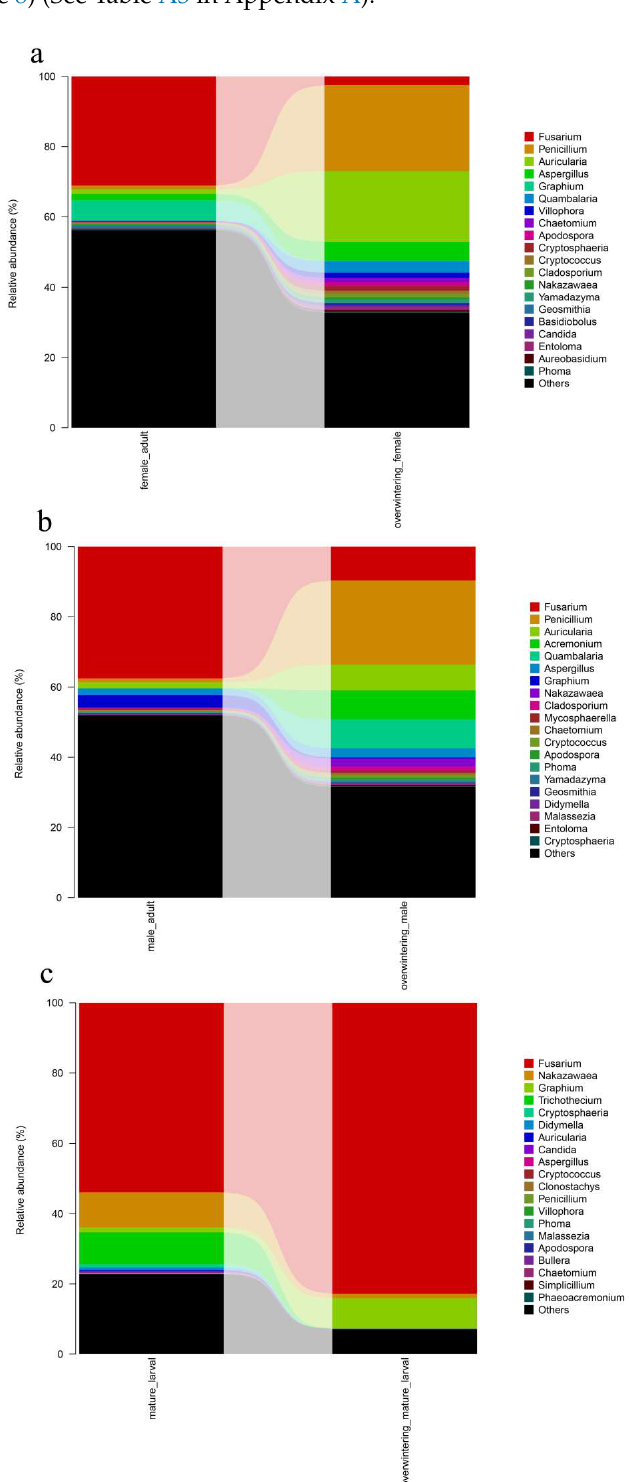
Figure 8. Fungal community structure variation in different generations of T. klimeschi at the genus level. ( a ) Adult females vs. overwintering adult females; ( b ) adult males vs. overwintering adult males; ( c ) mature larvae vs. overwintering mature larvae.